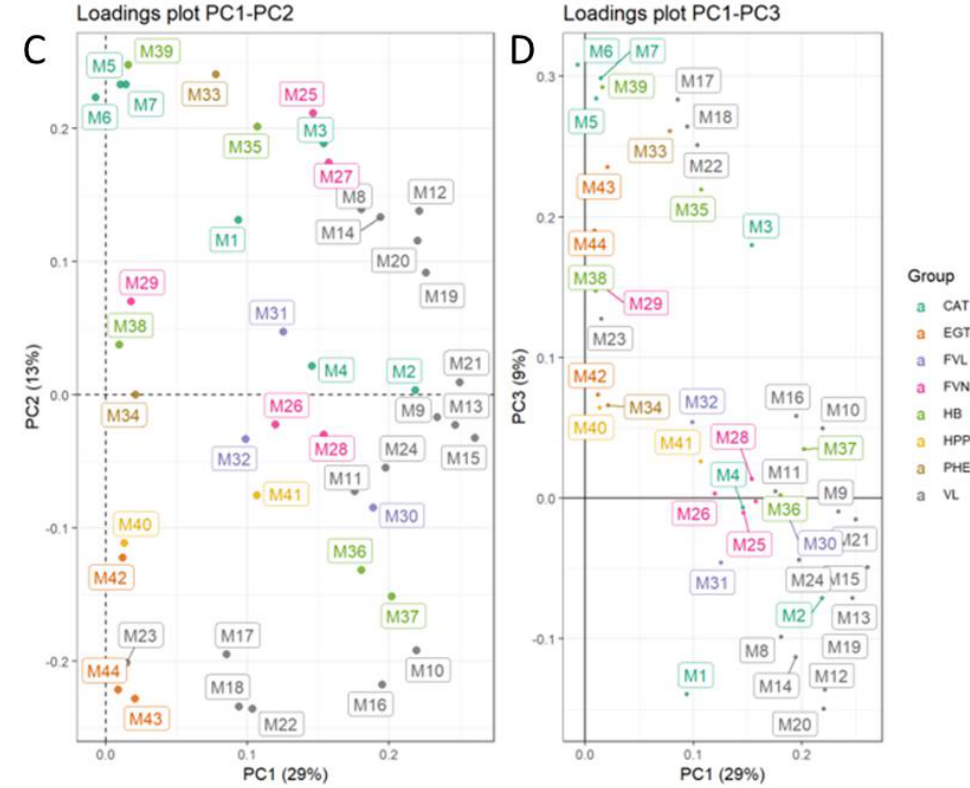
Figure 7. Inter-individual variability for urinary metabolites illustrated through principal component analysis. (PCA). ( A ) Score plots of PC1 versus PC2 for all the volunteers and ( B ) Score plots of PC1 versus PC3; ( C ) Loading plots of PC2 versus PC1 for all urinary metabolites and ( D ) PC1 versus